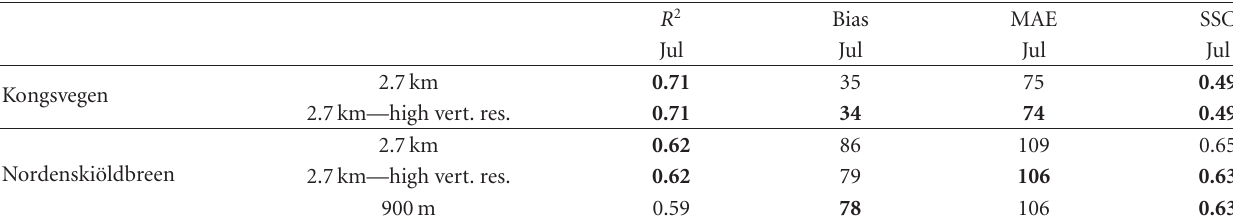
Table 16: Short-wave radiation statistics in summer and winter 2009-2010 in 2.7km resolution, with and without increased vertical resolution in the boundary layer (high vert. res.), and in 900 m resolution. Bold numbers indicate the best result for each AWS. Vestfonna data are not used here because of the lack of data during the chosen